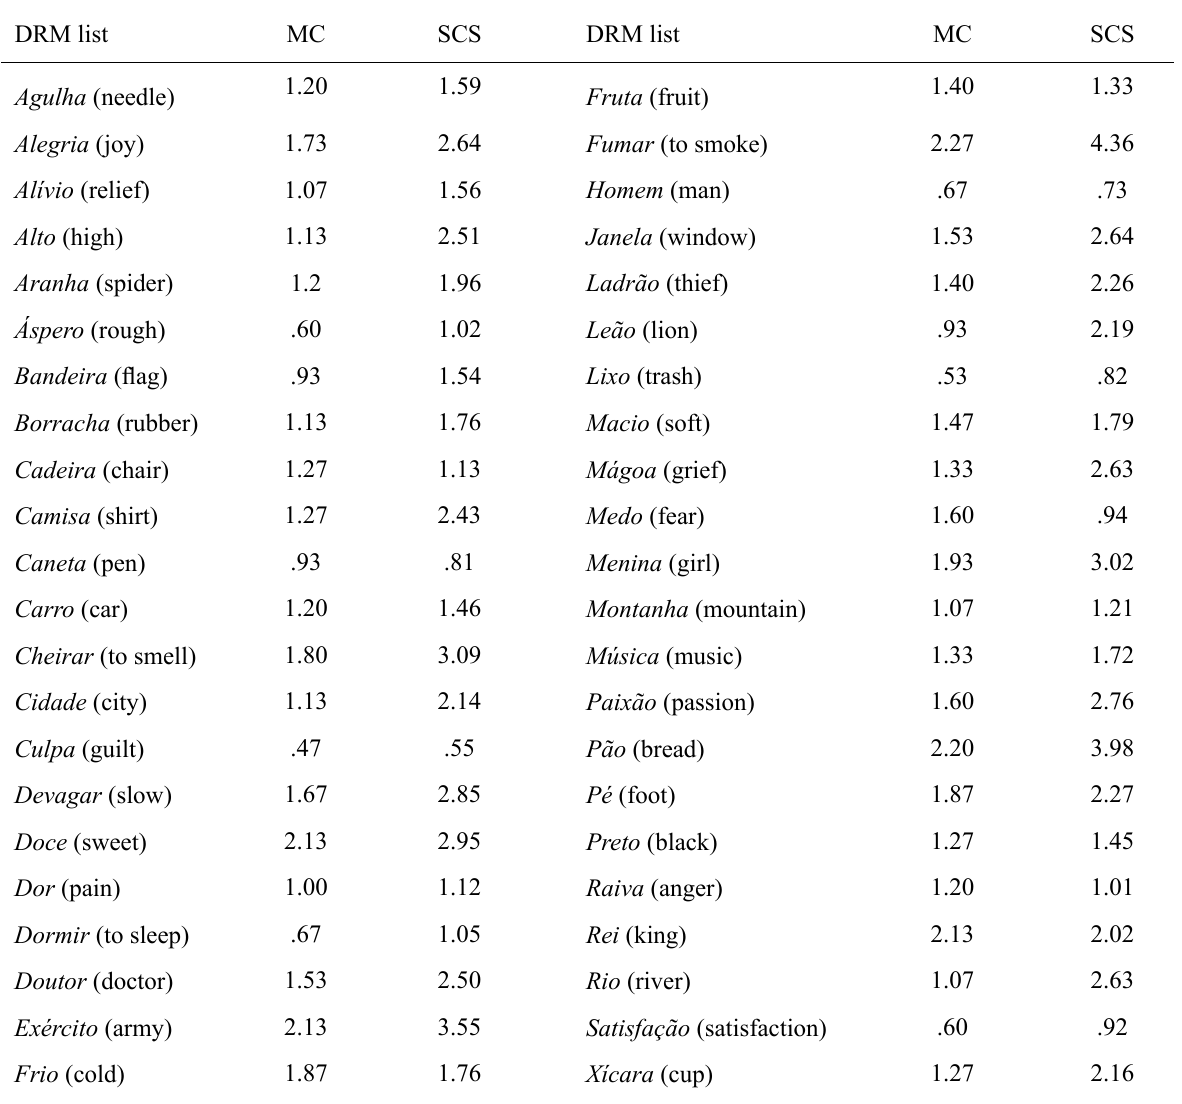
Mean Connectivity (MC) and Summed Connectivity Strength (SCS) for the 44 Word Lists from the Brazilian Version of the Deese/Roediger-McDermott Paradigm (DRM